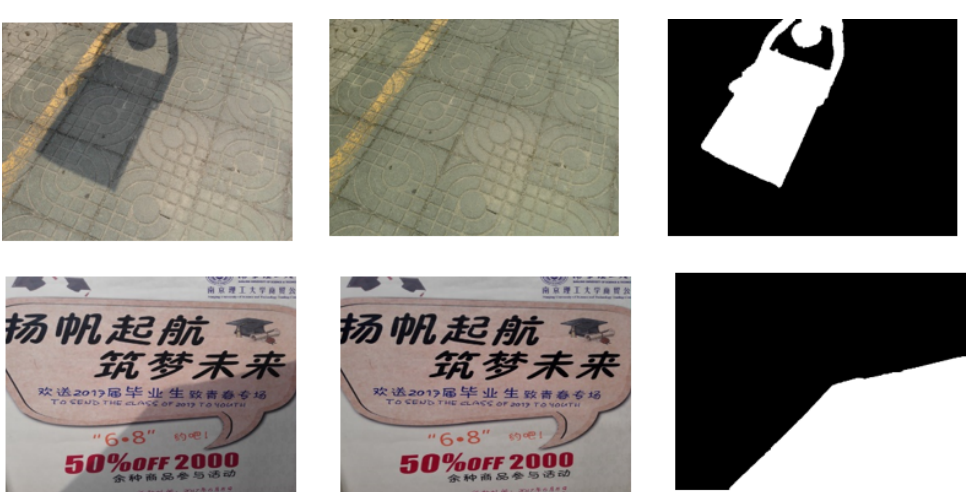
Figure 2. Some samples from the Image Shadow Triplets dataset (ISTD) [9]. The first column is the shadowed image, the second column represents the ground truth, and the last column is the mask of shadows. The purpose of our work is to restore a shadowed image into a shadow-free image and keep it similar to the ground truth as much as